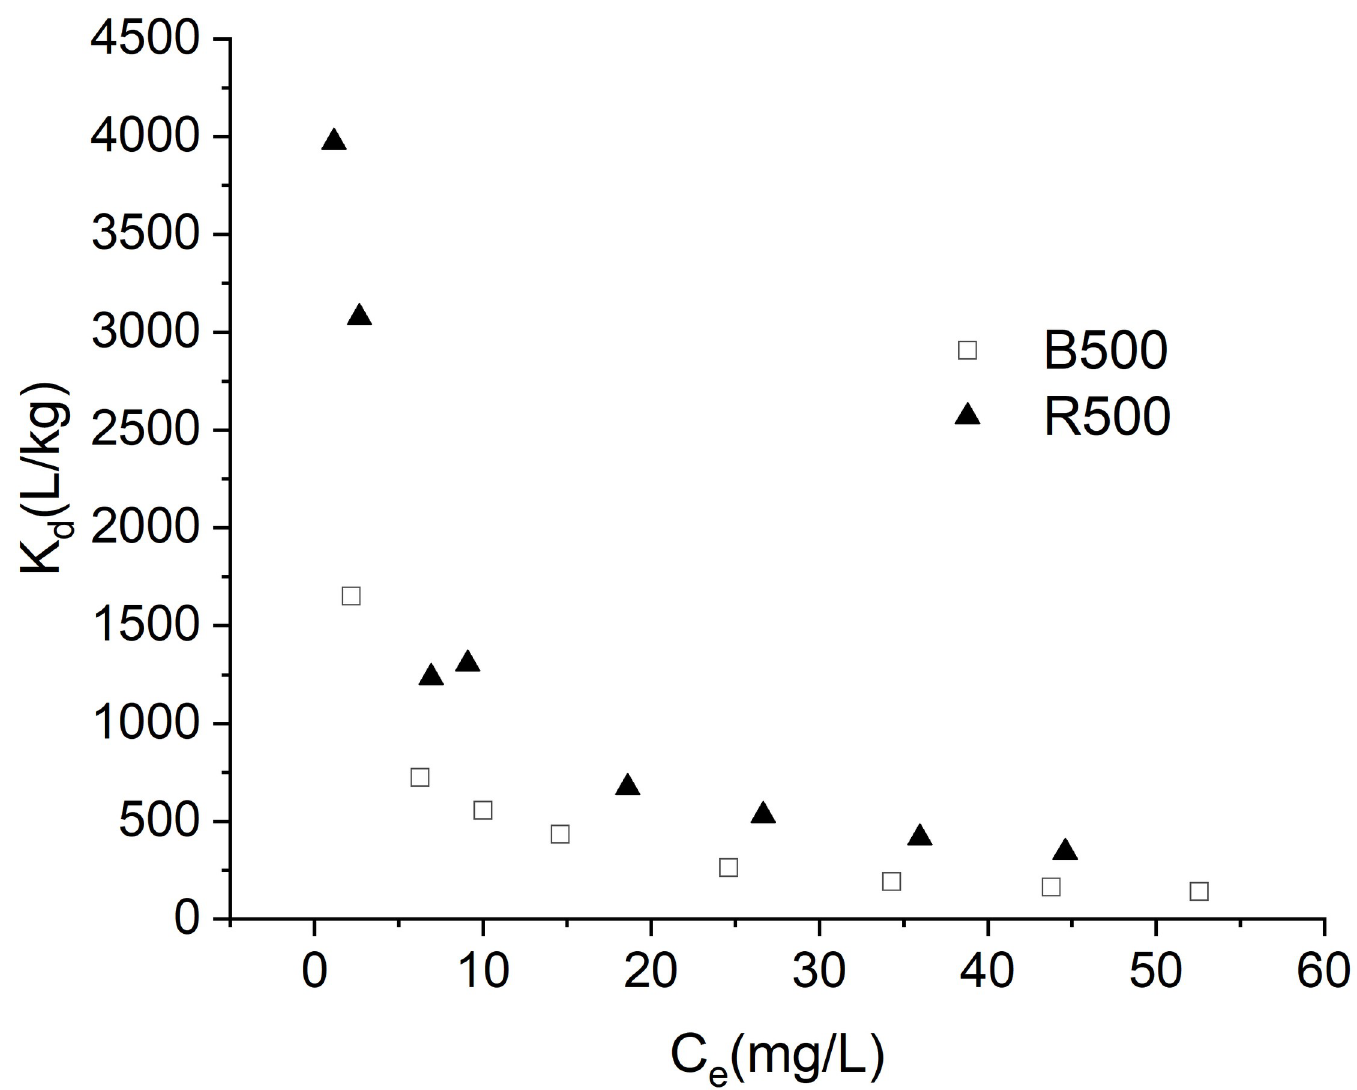
Fig 8. Adsorption coefficient (K d ) values for sorption of Basic Red 46 on biochar.